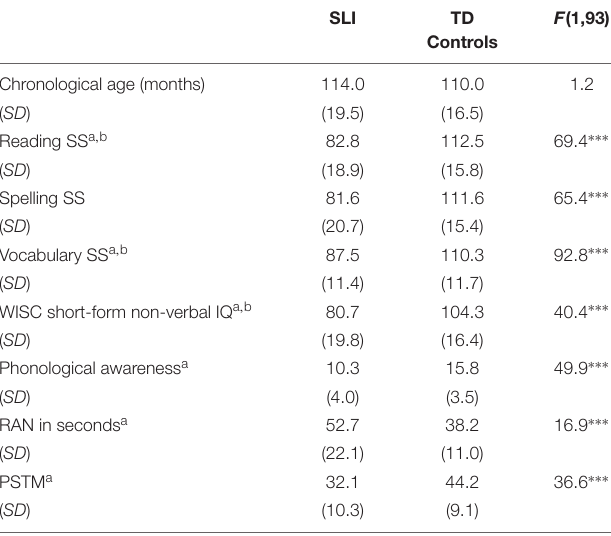
TABLE 5 | Participant details for full sample, Experiment